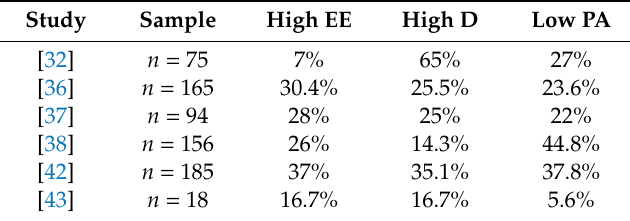
Table 2. Prevalence of high EE, high D, and low PA in palliative care nurses. Study Sample High EE High D Low PA [32] n = 75 7% 65% n =